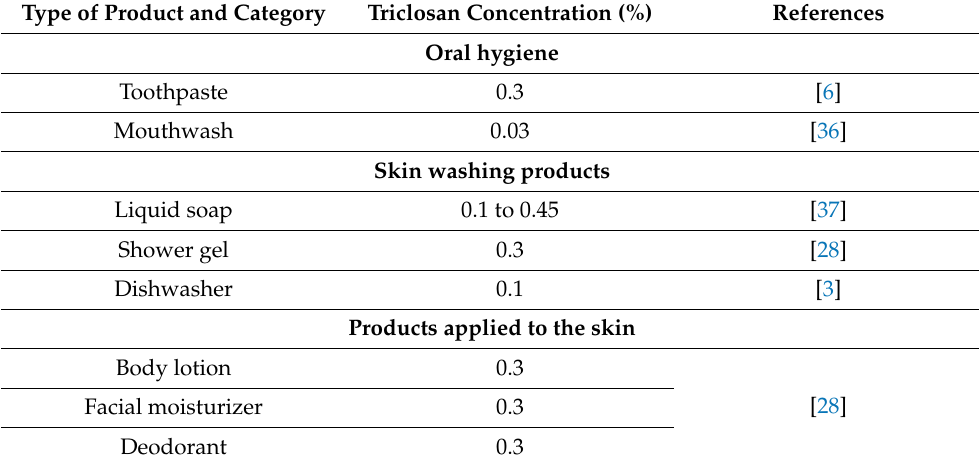
Table 3. Concentration of triclosan in personal care products. Type of Product and Category Triclosan Concentration